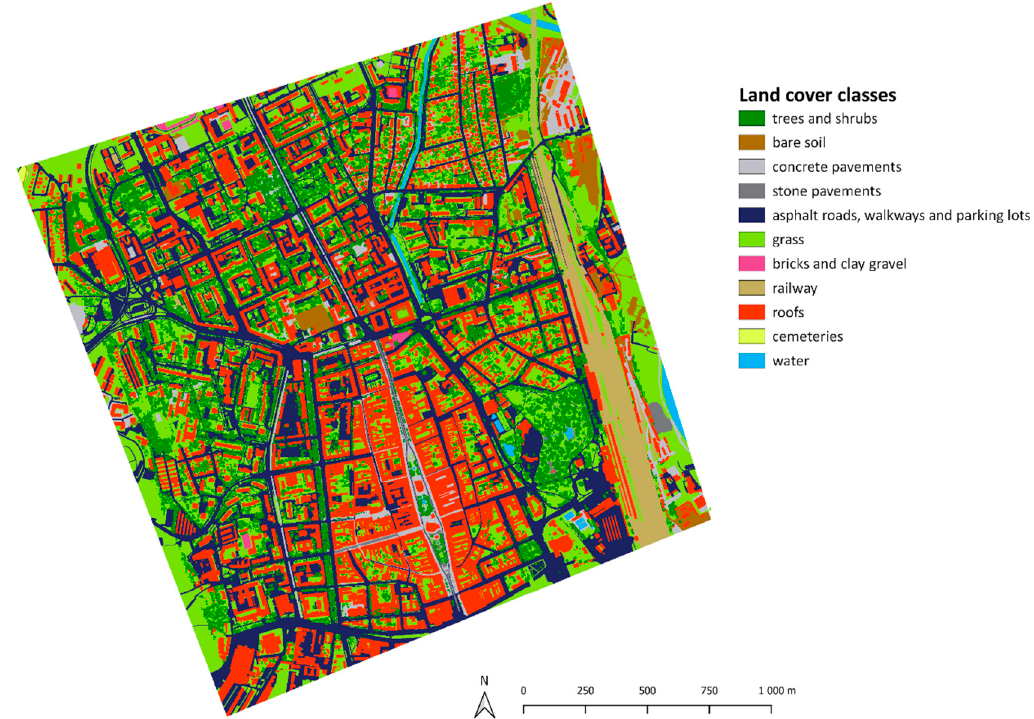
Figure 3. Land cover interpreted from aerial orthoimagery and by field inspection. Table 1. Convective heat transfer coefficient ( h c ) values estimated for 25 June 2020 based on land cover classes and meteorological situation.